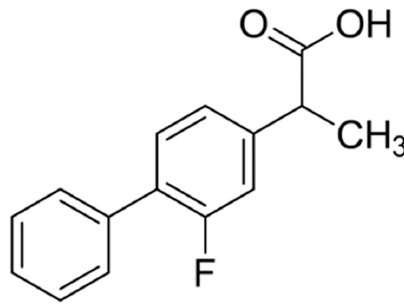
Figure 1. Chemical structure of flurbiprofen (FBF; M.W. 244.33, pKa 4.4).